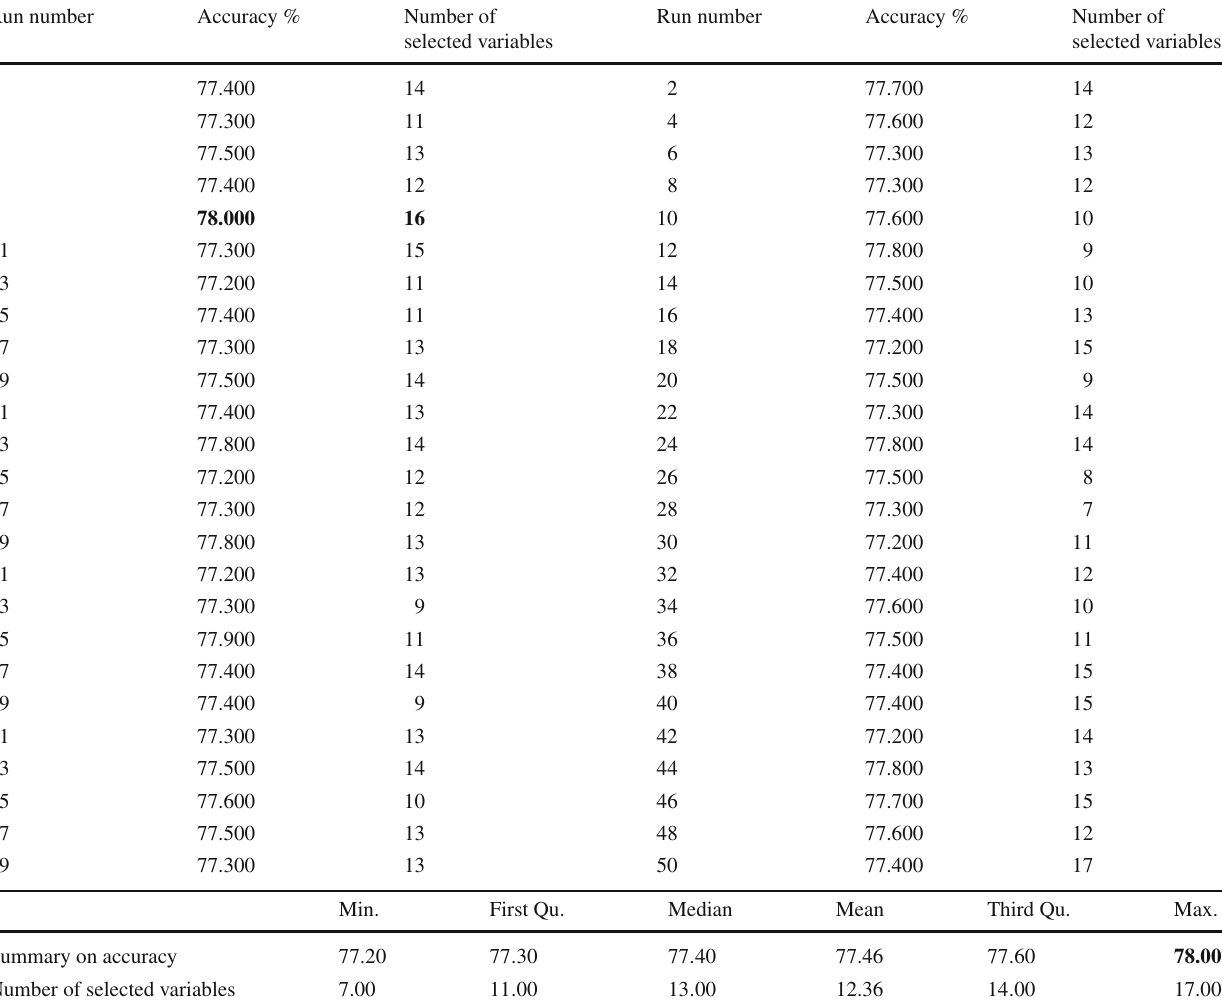
Table 7 The results of 50 run of VNS+SVM on German dataset Run number